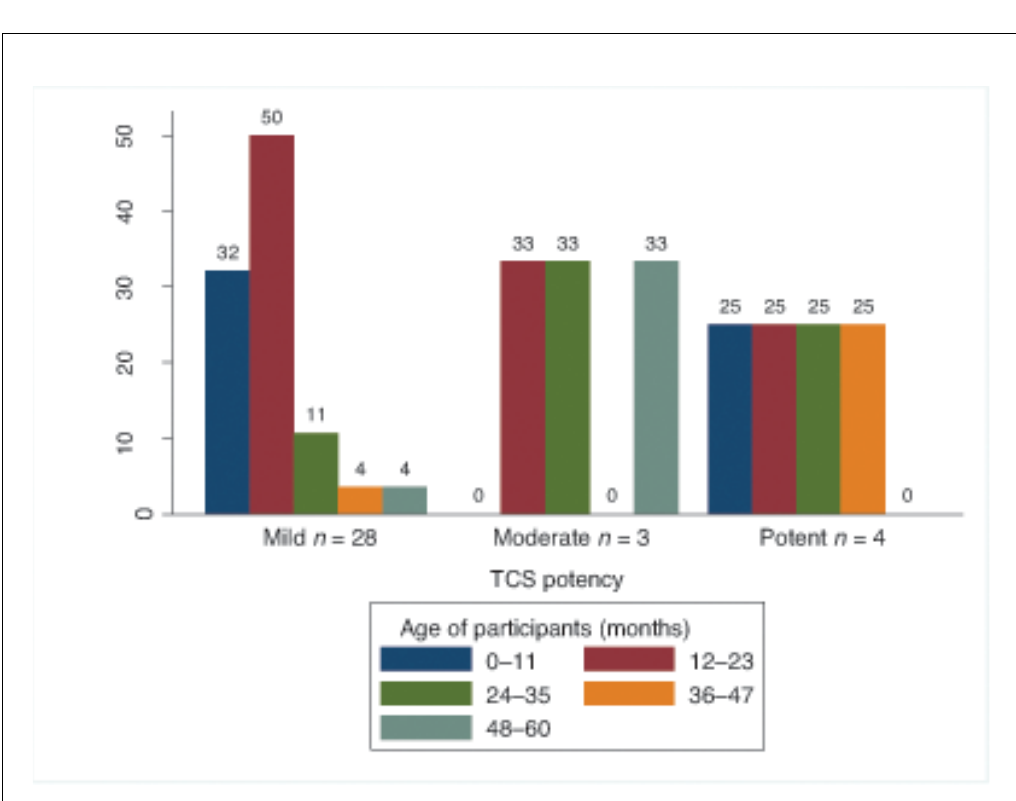
Figure 3. Topical corticosteroid potency by participant